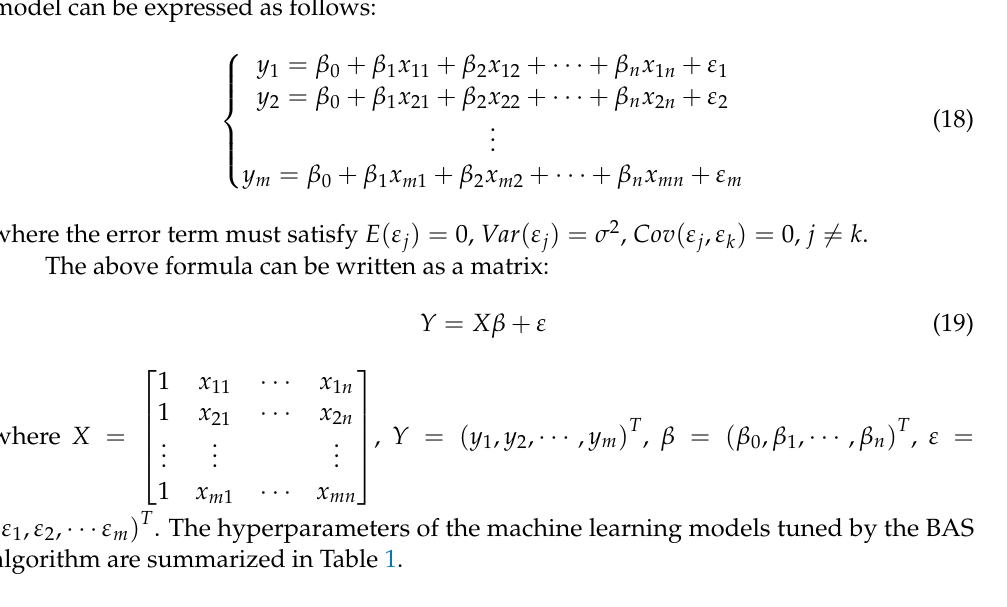
Table 1. Hyperparameters of the machine learning models tuned by the BAS